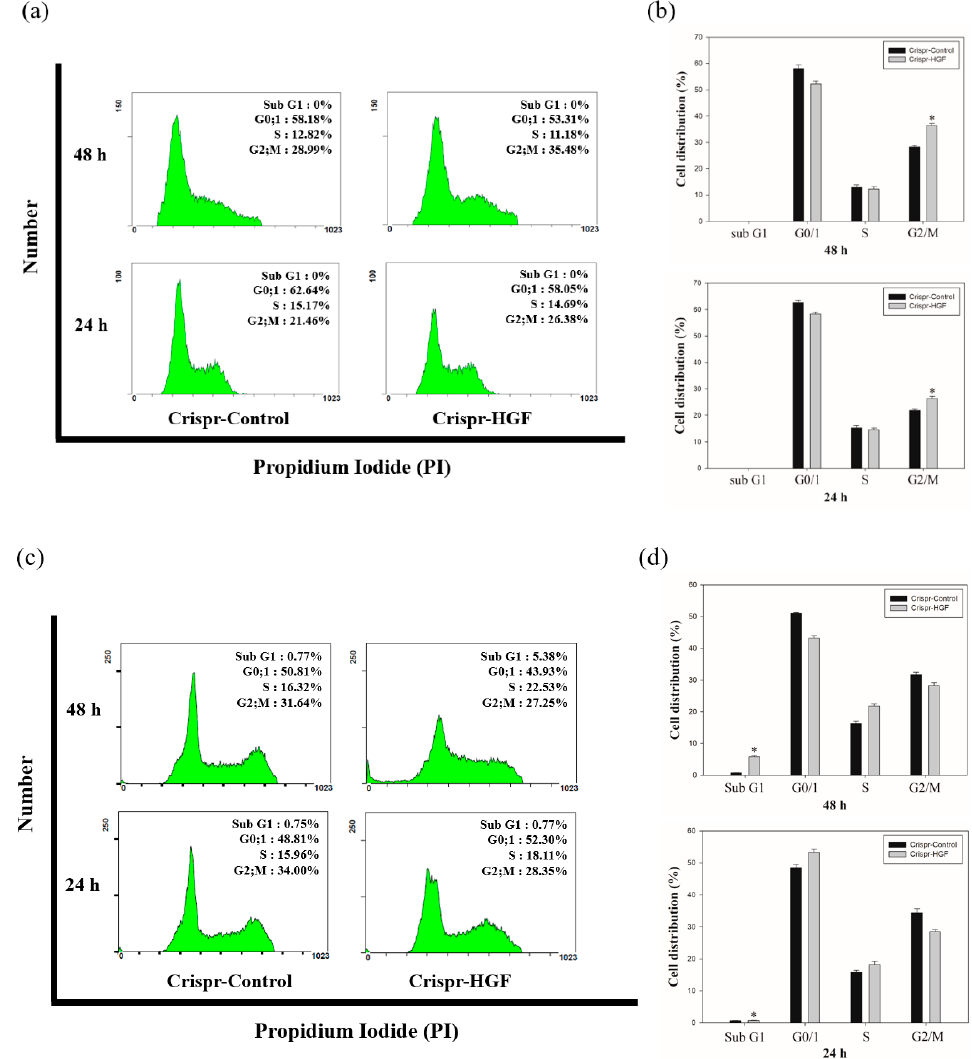
Figure 8. Cell cycle arrest in Crispr ‐ HGF ‐ transfected Huh7 and Hep3B cells. The cells were transfected with Crispr ‐ Control and Crispr ‐ HGF for 24 and 48 h and stained with propodium iodide (PI). After staining, the cells were detected using flow cytometry. The distribution and cell percentages of each cell cycle phase were evaluated. ( a ) G2/M cell cycle arrest in a time ‐ dependent manner against Huh7 cells. ( c ) G0/1 cell cycle arrest and subG1 cell cycle arrest in a time ‐ dependent man ‐ ner against Hep3B cells. ( b , d ) The results were analyzed statistically using the Student’s t ‐ test and the graph indicated the cell cycle distribution for each group. Error bar represents the mean ±SEM. * p < 0.05. These assays were performed at least three times in triplicate.